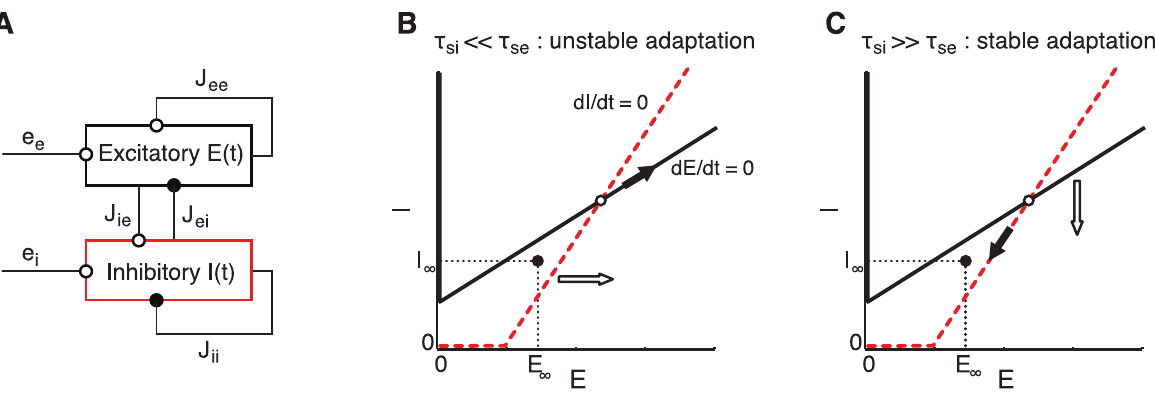
Figure 4. Connectivity and dynamics of the mean-field description of a recurrent network with HSE. A: Scheme of the structure of the network model. The excitatory ( E ) and the inhibitory population ( I ) connect to themselves (through J ee and J ii ) and to each other (through J ei and J ie ). Both populations receive excitatory input from external sources ( e e and e i ). B–C: The E , I -phase plane showing the nullclines dE = dt ~ 0 (solid line) and dI = dt ~ 0 (dashed line). The intersection of the nullclines gives the activity state of the network (open circle). The target state E ? , I ? is indicated by the filled circle. Recurrent excitation is strong (i.e., g e J ee w 1 ), giving the dE = dt -nullcline a positive slope. This strong recurrent excitation can lead to unstable adaptation dynamics, depending on the relative size of the adaptation time scales of the inhibitory population, t si , and the excitatory population, t se (see equation (3)). Adaptation is unstable (B) when t si % t se : the dI = dt -nullcline shifts rightward (open arrow) to decrease excitability of the inhibitory population, thereby moving the network activity state along the dE = dt -nullcline away from the target state (filled arrow). Adaptation is stable (C) when t si & t se : the dE = dt -nullcline moves downward (open arrow) to decrease excitability of the excitatory population and the activity state moves along the dI = dt -nullcline toward the target state (filled arrow).